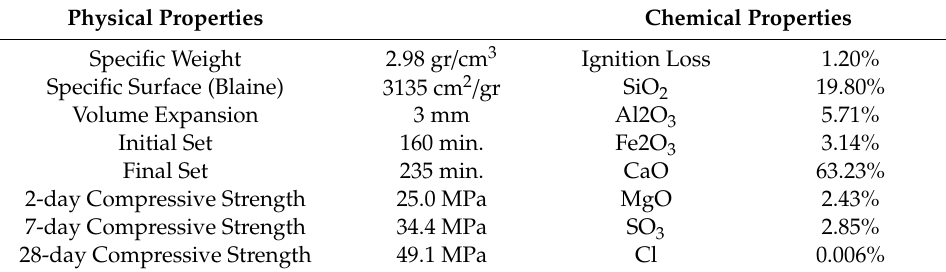
Table 3. Composition of di ff erent concrete used for concrete silo construction